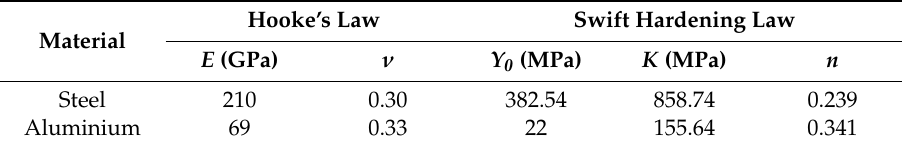
Table 1. Material parameters of the metallic outer